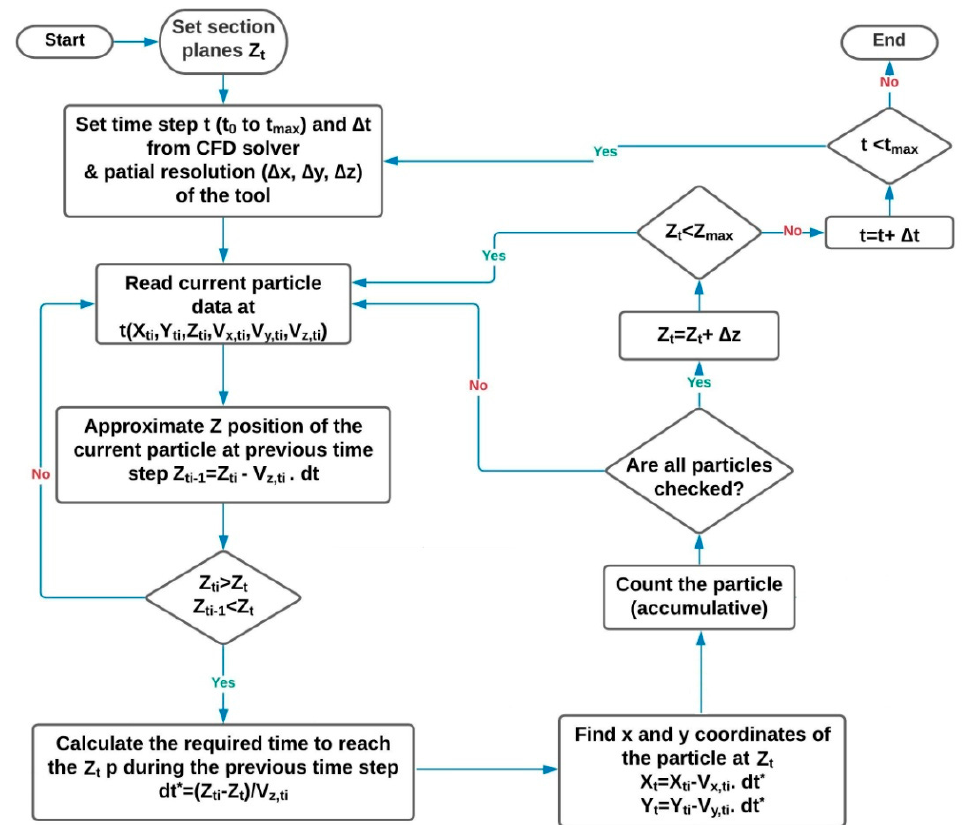
Figure 5. Flowchart of risk assessment of accumulated droplets of respiratory events.